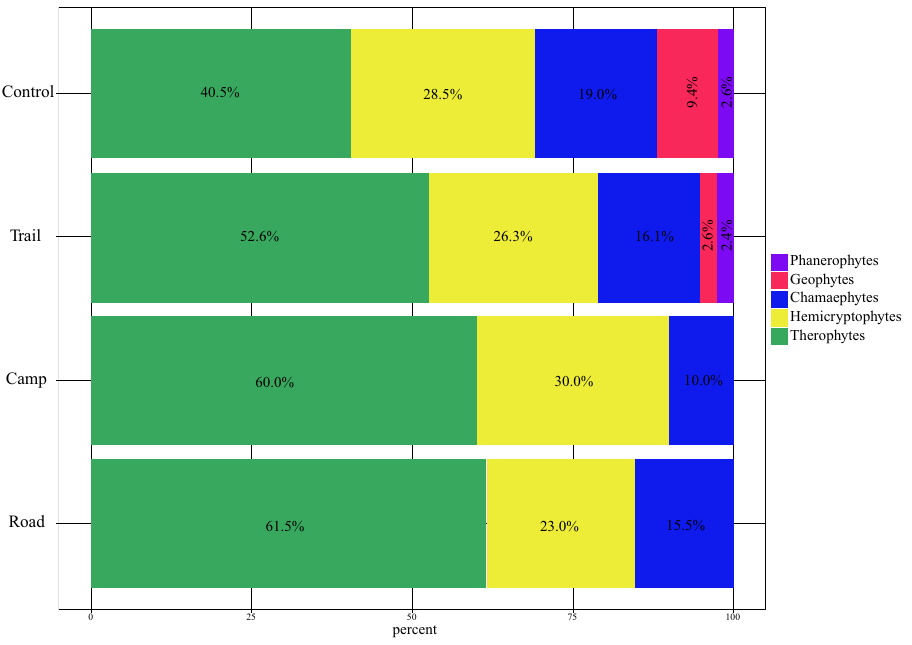
Figure 1. Raunkiær life form spectrum for the three disturbance types (hiking trail, dirt road, campsite) and control